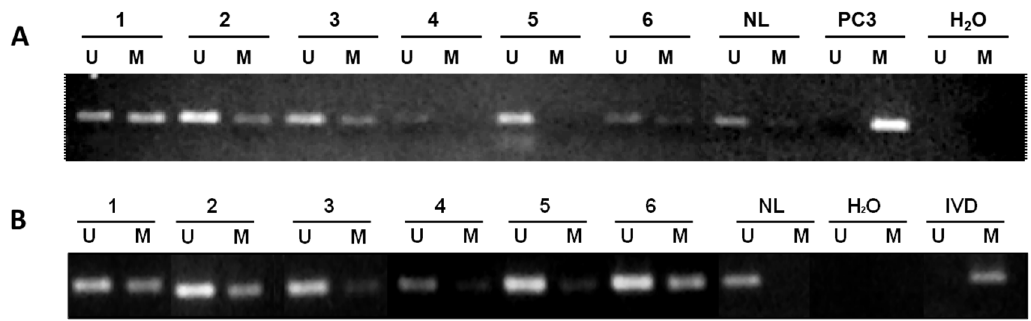
Figure 5. Analysis of Gfi1 methylation in primary human tumors. ( A ) Prostate cancer. ( B ) Breast cancer. The presence of a PCR band under the lane M indicates methylated genes, whereas the presence of a PCR band under the lane U indicates unmethylated genes. Normal lymphocytes (NL) and in vitro methylated DNA (IVD) and DNA from PC3 cells are used as negative and positive control for unmethylated and methylated genes,